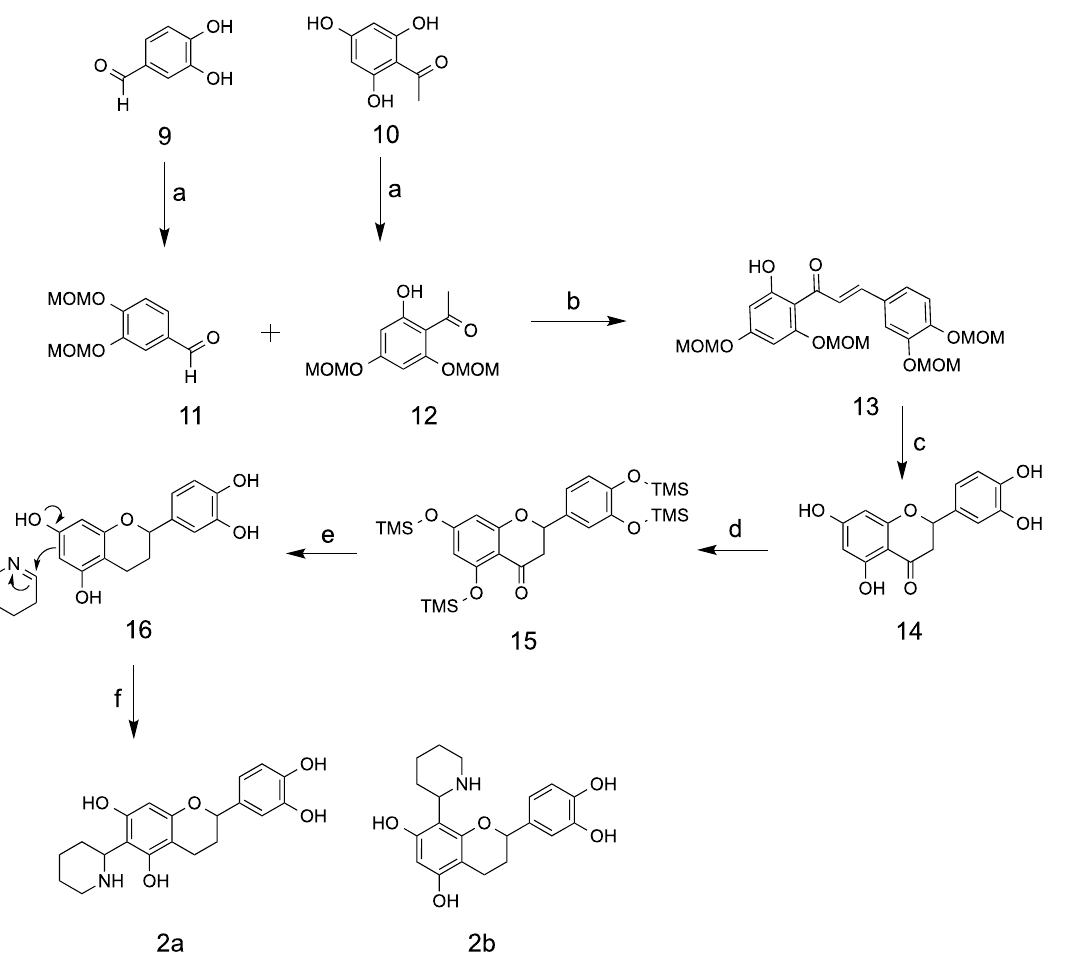
Scheme 1. The synthesis of Δ 1 -piperidein intermediate. Reaction conditions and reagents: ( a ) ether,